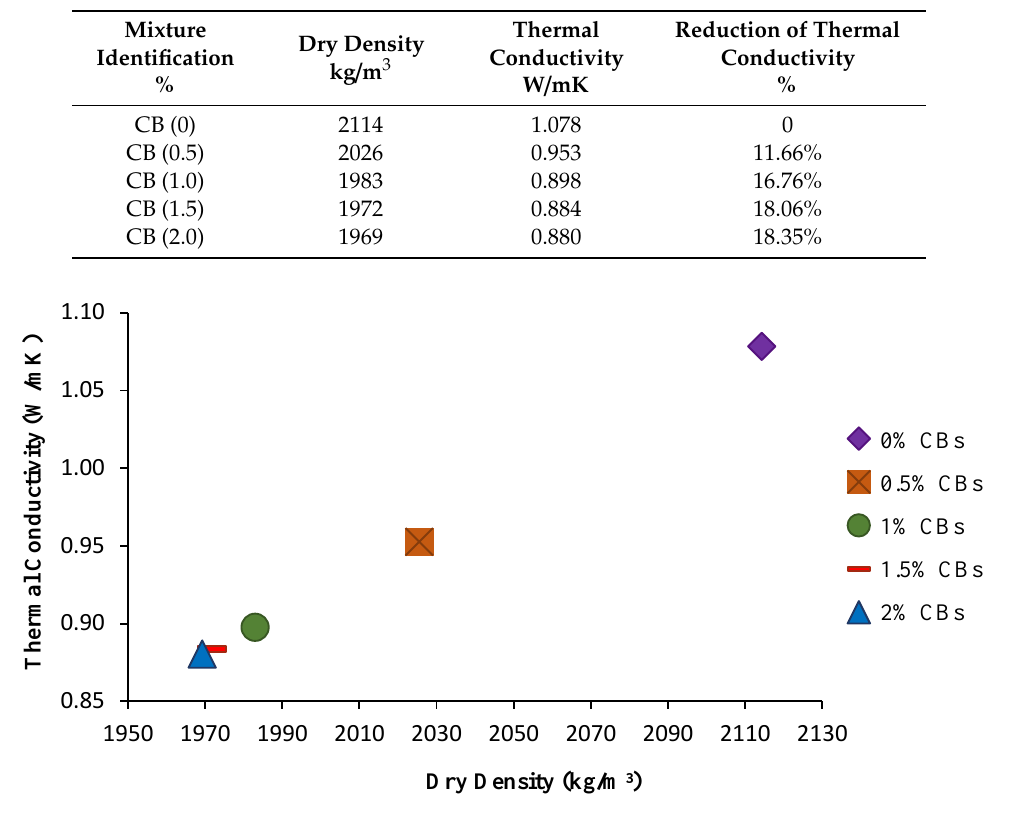
Figure 17. Thermal conductivity of each brick sample.